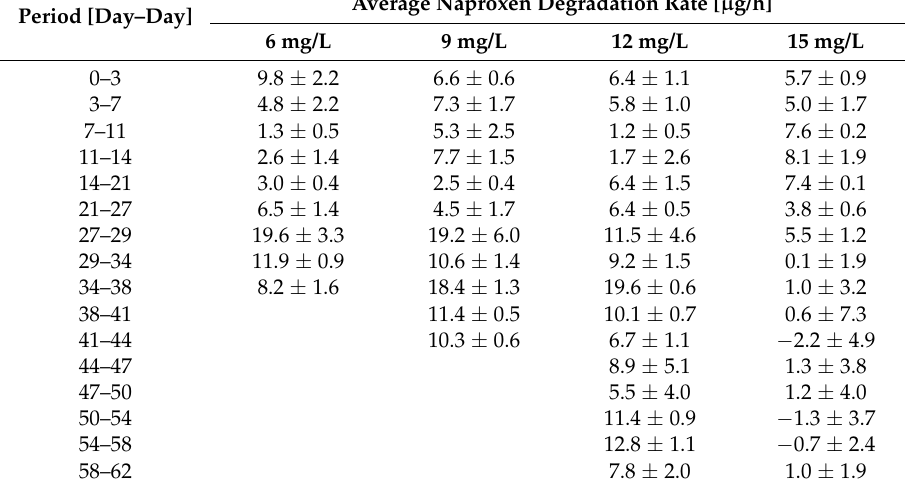
Table 1. Naproxen degradation rates by free cells of Planococcus sp. S5. Data presented as a mean ± standard deviation of three